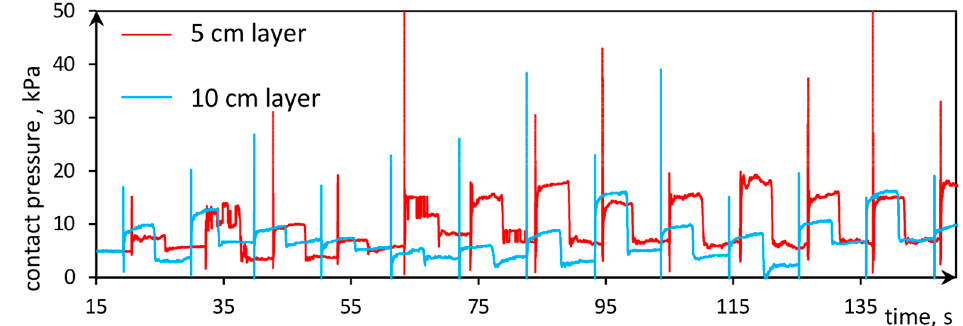
Figure 14. Contact pressure below the 5 and 10 cm compacted layer obtained by the tactile sensor.